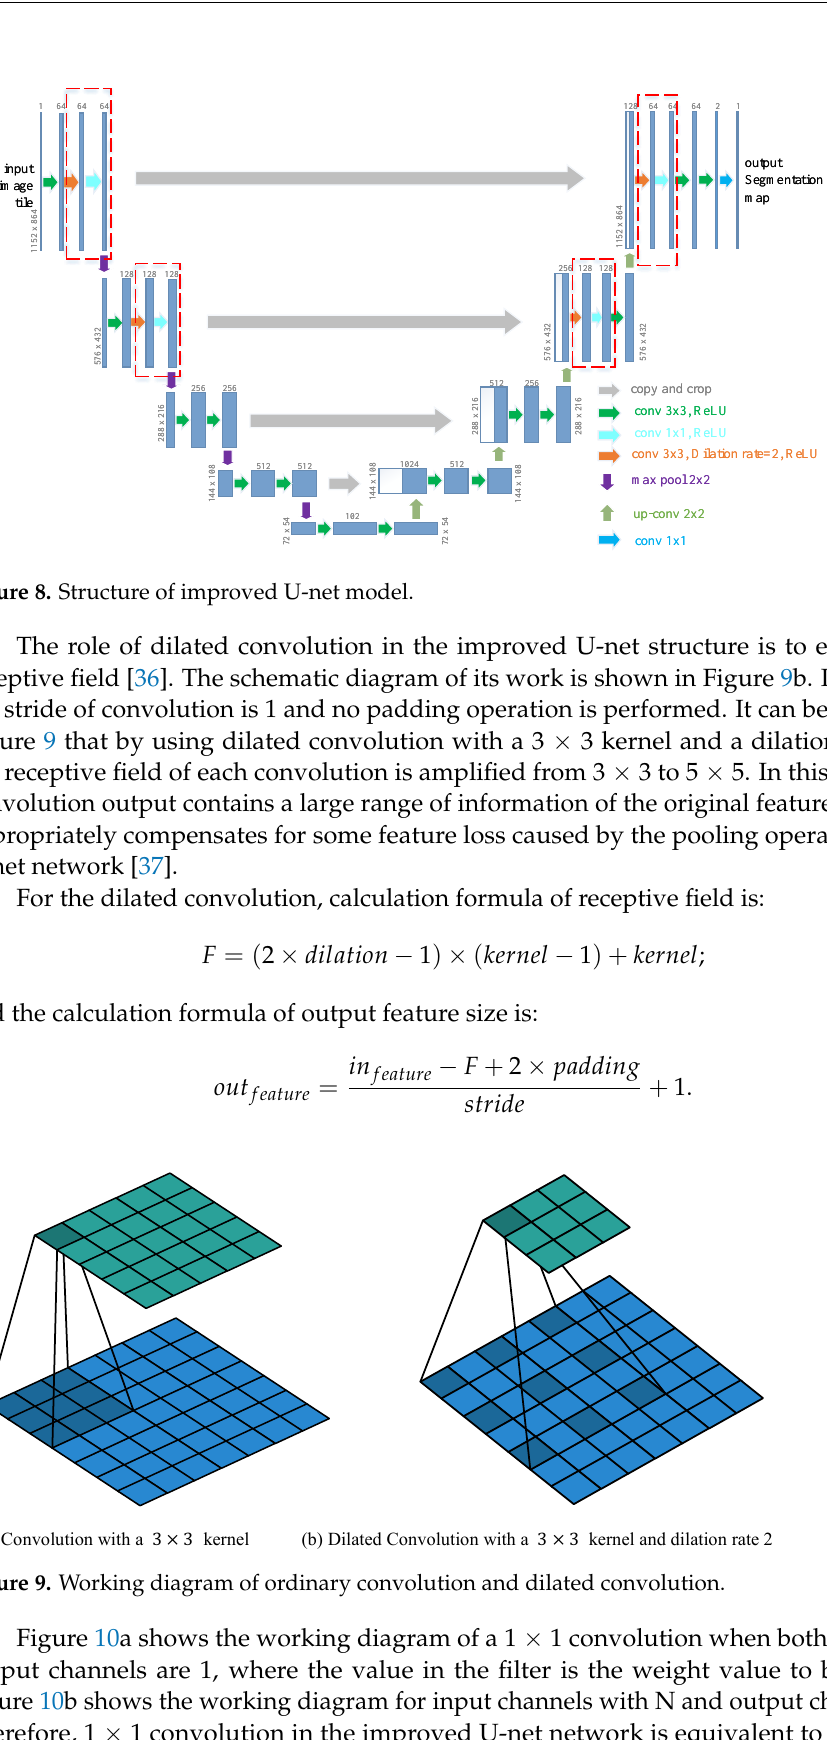
Fig. 8 Working diagram of ordinary convolution and dilated convolution. Figure 9. Working diagram of ordinary convolution and dilated convolution when both input and output 1 × 1 convolution in the improved U-net network is equivalent to adding an auto-learnable coefficient 1 × 1